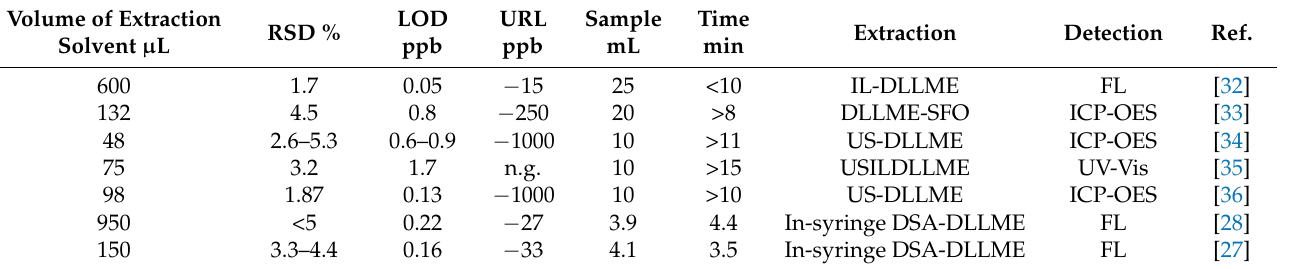
Table 1. Comparison of several methods for aluminum determination using solvent emulsification or